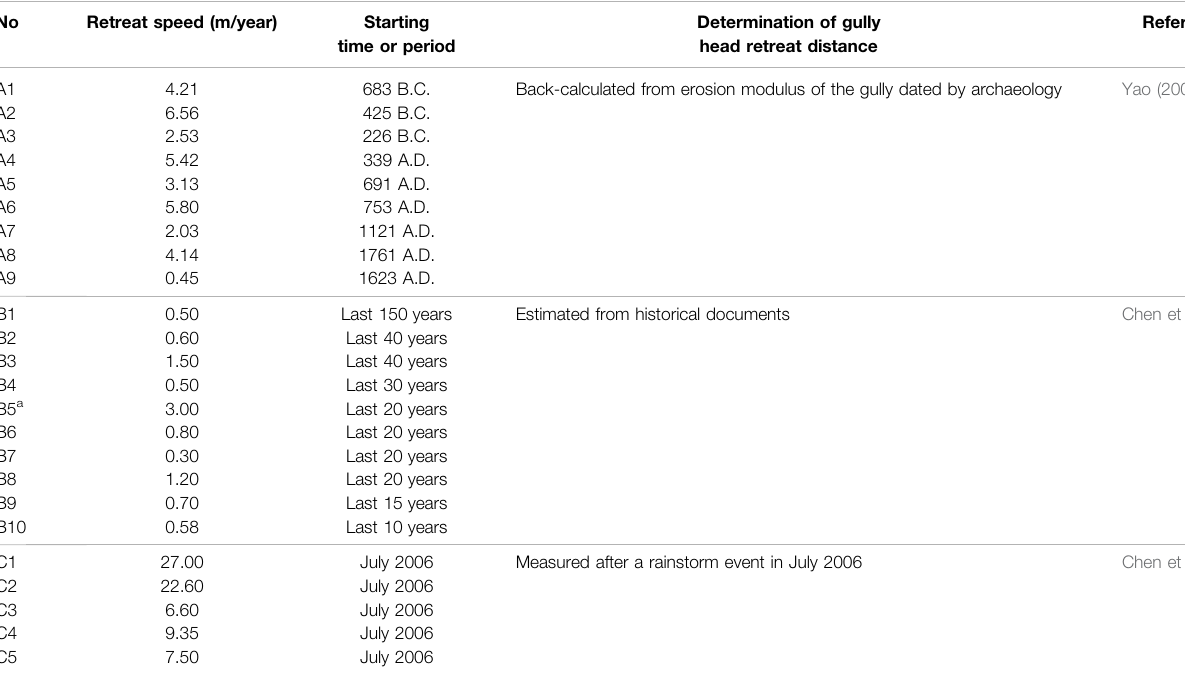
TABLE 1 | Speed of gully head retreat estimated by different methods.